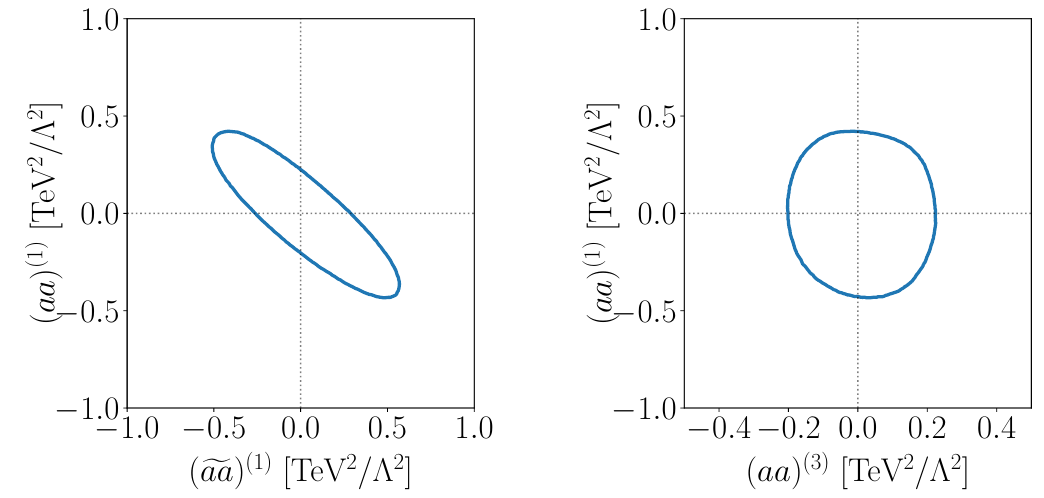
Figure 4 . Bounds on the flavor structure of the four-quark interactions O (1) qq and O (3) qq from a 4-parameter fit to dijet angular distributions measured at the LHC [85]. We show contours for ∆ χ 2 = 5 . 99 . The flavor parameters are defined at µ = 2 . 4 TeV. 0